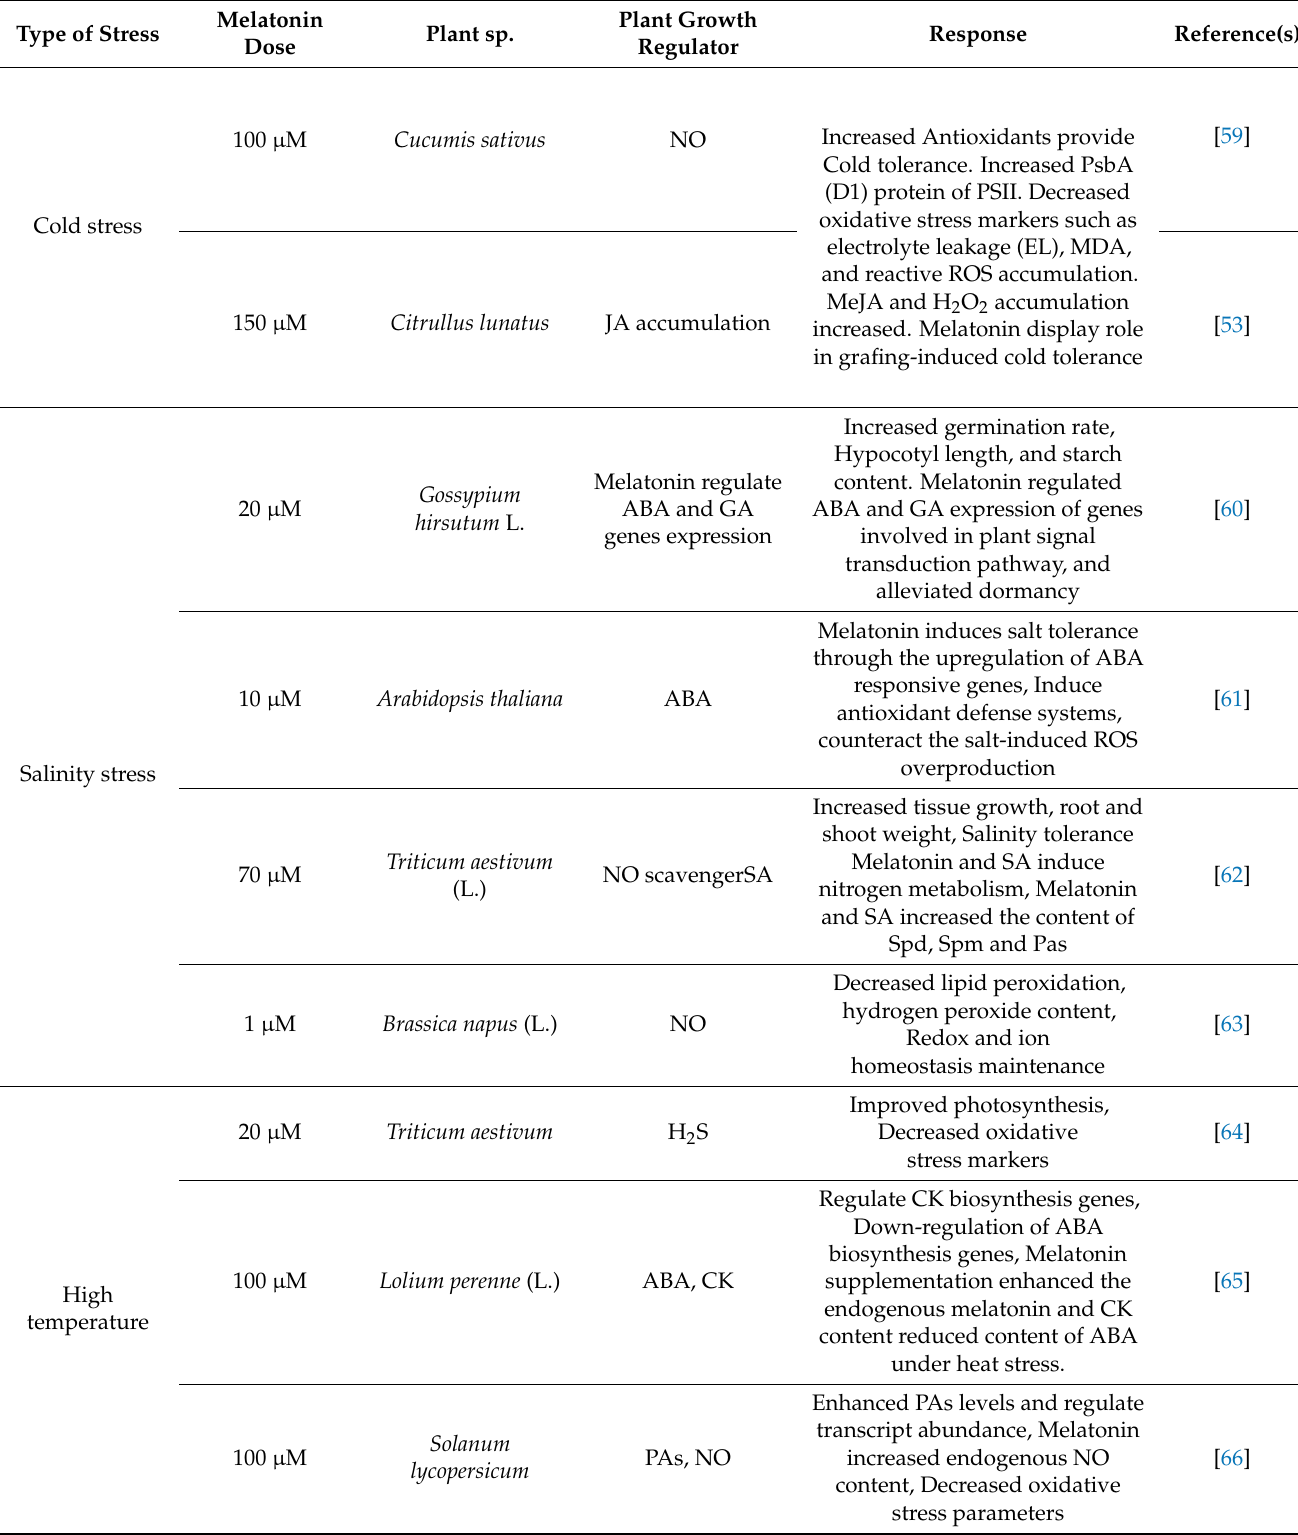
Table 1. Melatonin functioning in relation to Plant growth regulators under different stress